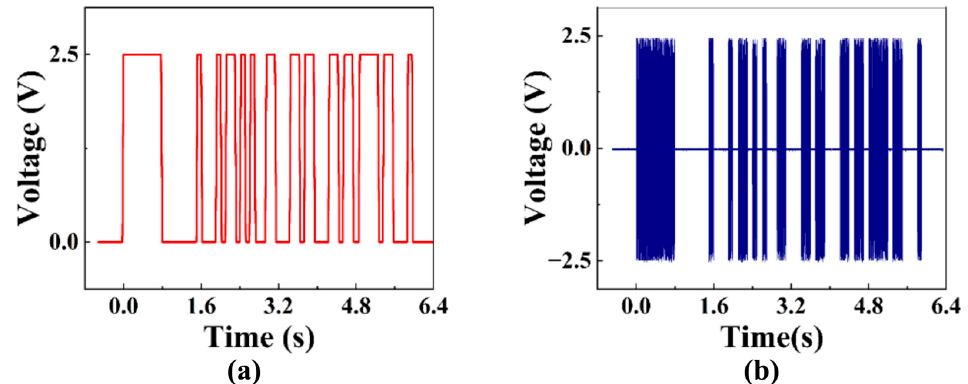
Figure 7. Measured time domain signals from the transmitter side. ( a ) Source signals. ( b ) Modulated signals.